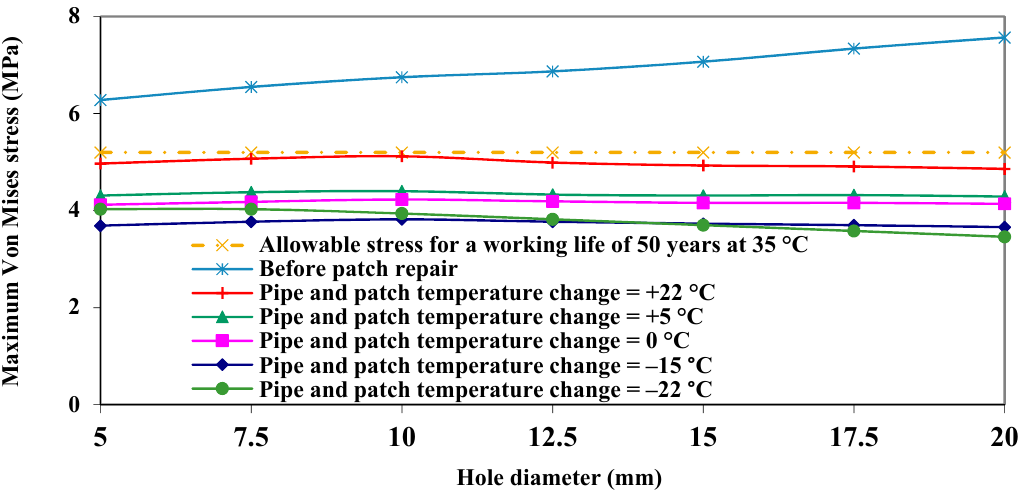
Figure 17. Maximum Von Mises stress in buried pipe for circular hole defects, saddle fusion patch repaired (simultaneous effects of soil load, internal pressure, vehicle load and temperature variations).